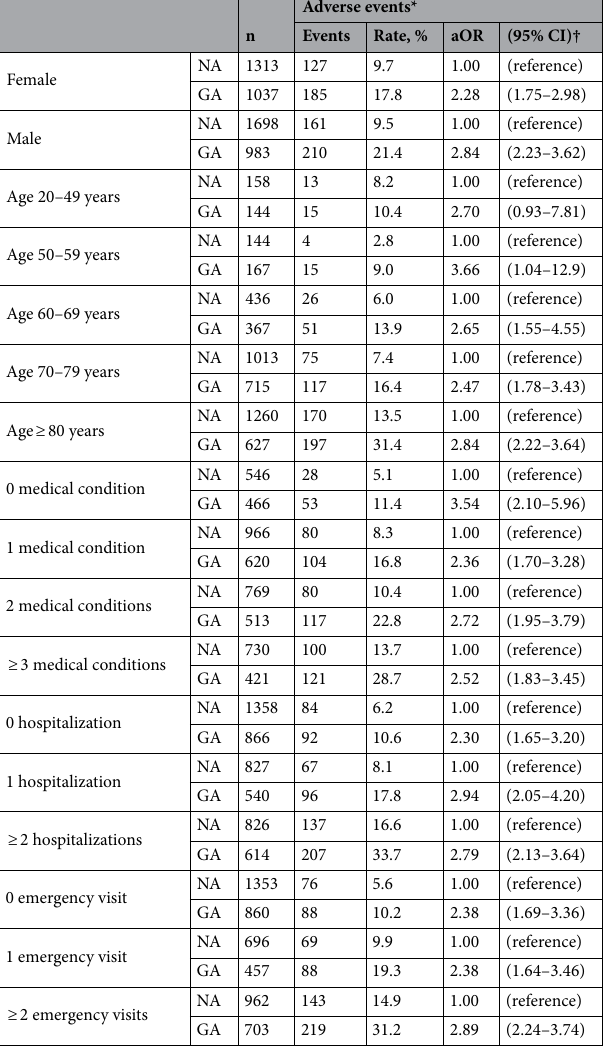
Table 5. The stratified analysis for the risk of adverse events after surgeries associated with general anesthesia (N = 5031). aOR adjusted odds ratio, CI confidence interval, OR odds ratio, GA General anaesthesia, NA Neuraxial anaesthesia. *Adverse events included with acute myocardial infarction, acute renal failure, pneumonia, septicemia, and intensive care unitICU stay. † Adjusted for all covariates listed in Table